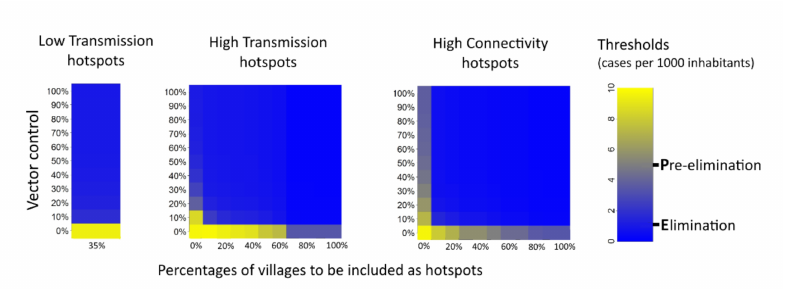
Figure 5. Malaria incidence in the year following mass drug administration associated with vector control. Various definitions of hotspots were tested. The x-axis represents the percentage of villages included as hotspots. The y-axis represents the decrease in mosquito bites from